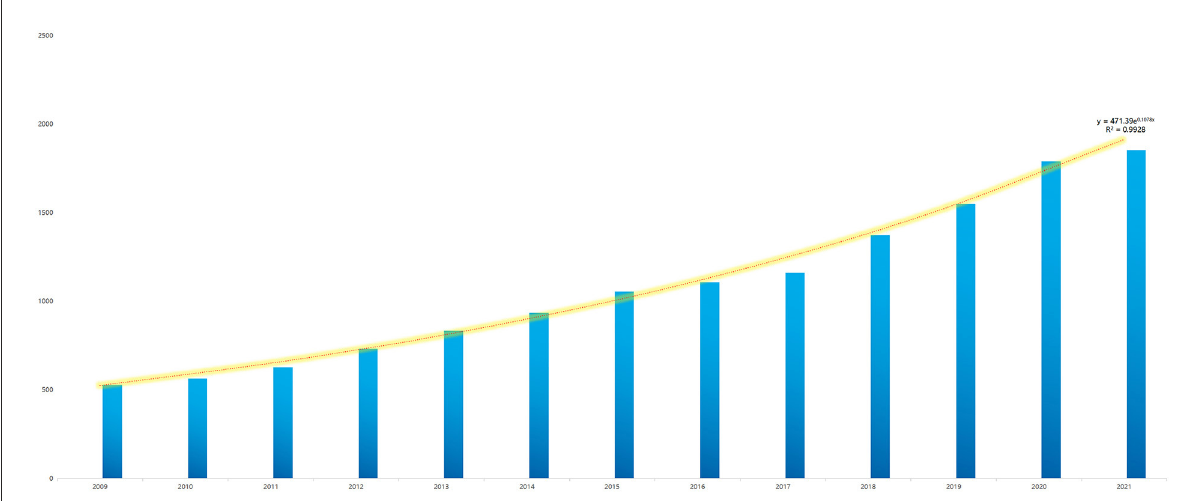
FIGURE1 Annual number of publications in depression biomarker research from 2009 to